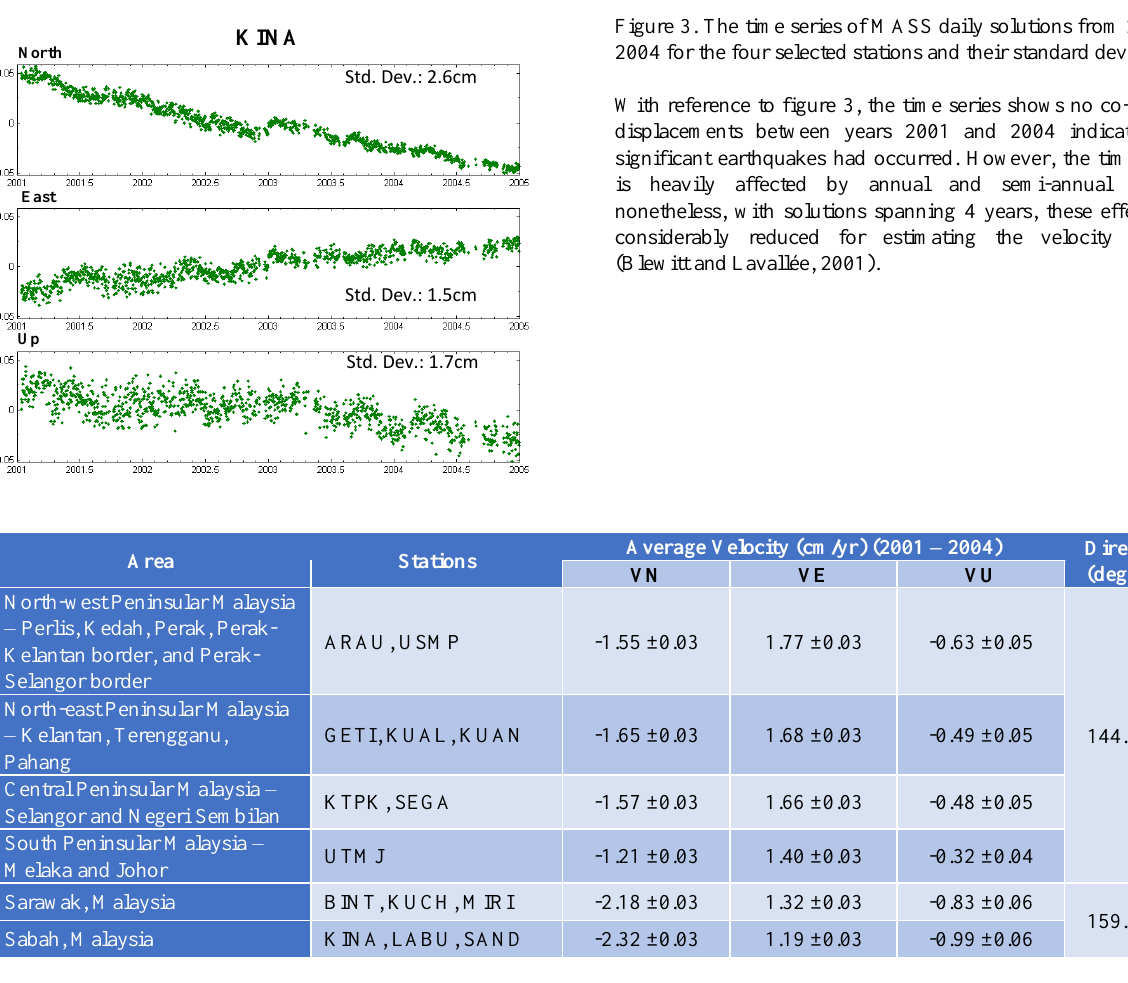
Table 2. Averaged velocities of Malaysia and their directions, categorised by area, from linear regression analysis of MyRTKnet station positions from 2001 to 2004 (before 2004 Sumatra-Andaman earthquake – 26 December 2004). Note that SEGA is located near the border of Johor-Negeri Sembilan; however, as the velocity is closest to KTPK, the authors decided to group it under Central to avoid any average bias. VN, VE, and VU represent the north component velocity, east component velocity, and up component velocity, and their standard errors, respectively